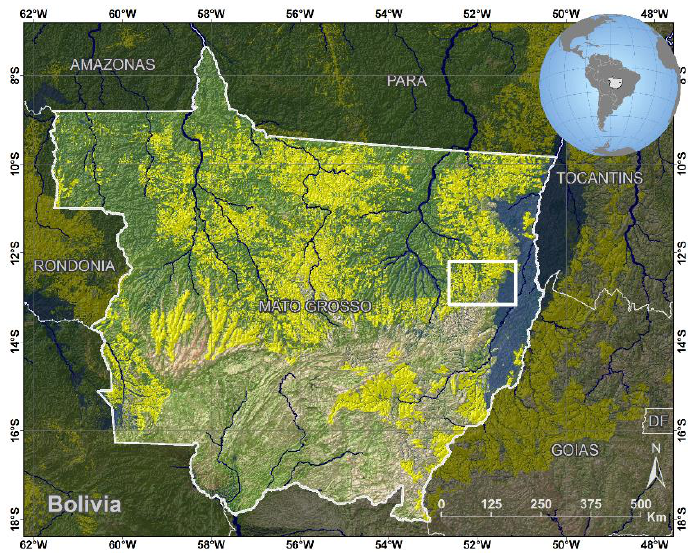
Figure 1. Study area (white rectangle) within Mato Grosso, Brazil.